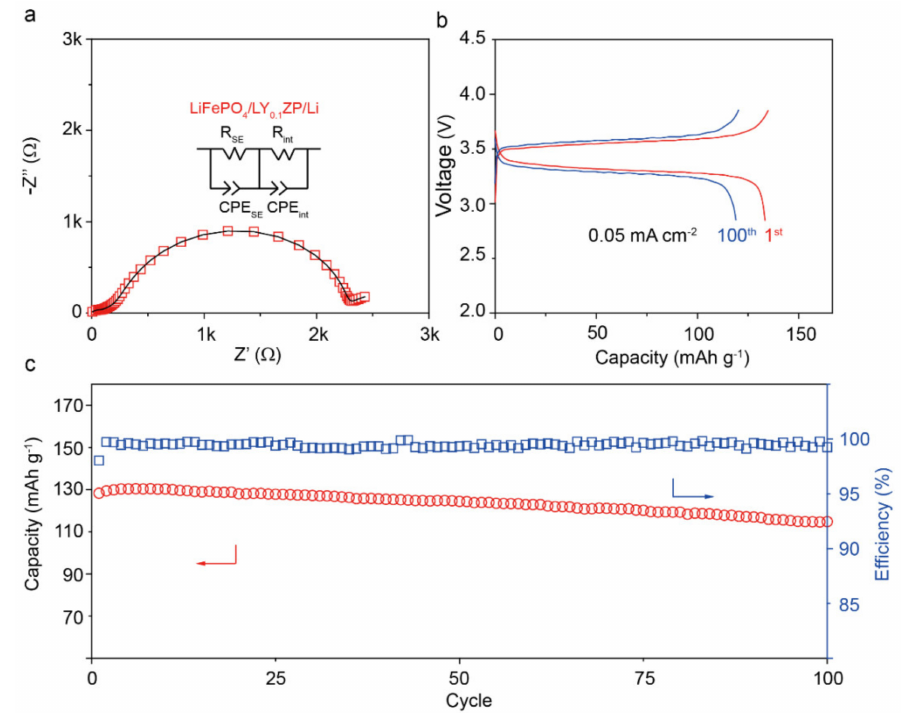
Figure 6. ( a ) Impedance profile of the all-solid-state LiFePO4 / LY0.1ZP / Li cell at 60 ◦ C. ( b ) Charge and discharge voltage profiles and ( c ) cycling performance of the all-solid-state LiFePO4 / LY0.1ZP / Li cell at 60 ◦ C. The size of the LiFePO4 was 0.5 cm − 2 .